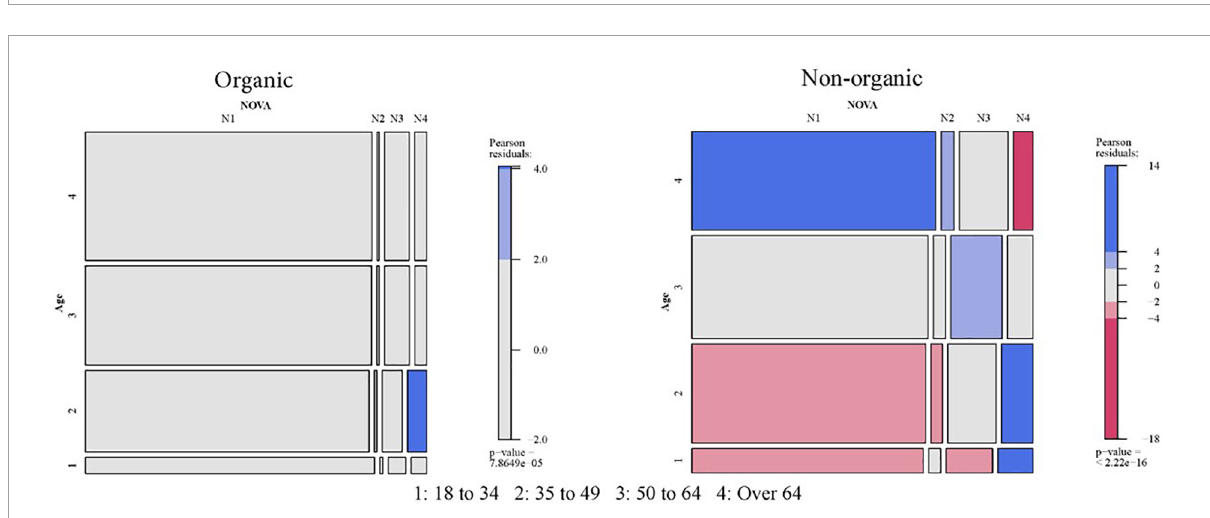
FIGURE5 Relationship between the age of the person responsible for household buys and NOVA: Organic vs. non-organic food purchases. 1: 18–34; 2: 35–49; 3: 50–64; 4: Over